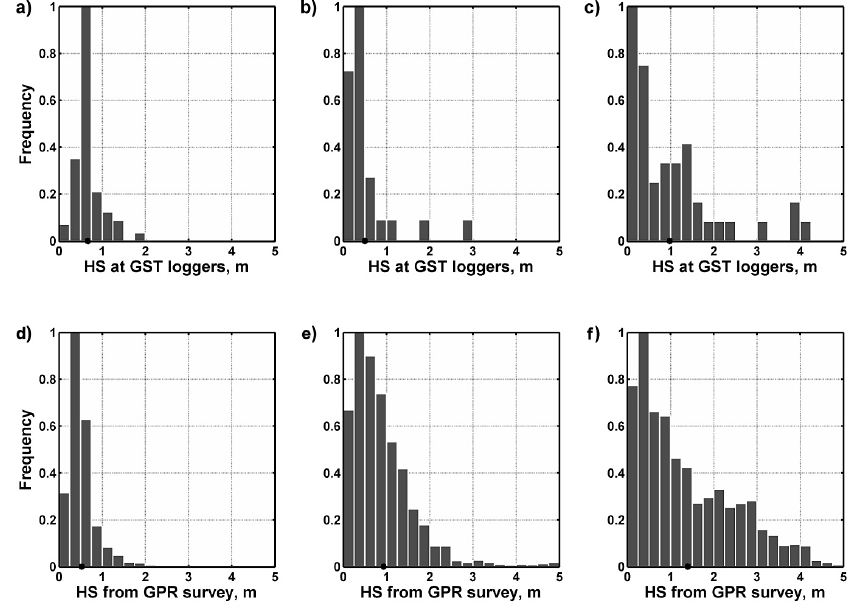
Figure 4. Distributions of the height of snow (HS) at the respective field sites (a) Ny-Ålesund, (b) Juvvasshøe and (c) Finse. Upper row: snow heights measured manually at each logger site; Lower row: snow heights from GPR snow surveys over a 1km × 1km area around the loggers. Black dot: average snow height. Table 2. Variation in observed mean annual ground surface temperatures (MAGSTs) for 2012–2013 at the study sites, given as mean, minimum, maximum and standard deviation of MAGSTs from all loggers at each site. The percentage of loggers with MAGSTs below 0 ◦ C is given under “%<0 ◦ C”, and the skewness of the distributions of MAGSTs is given as a number between − 1 and 1.